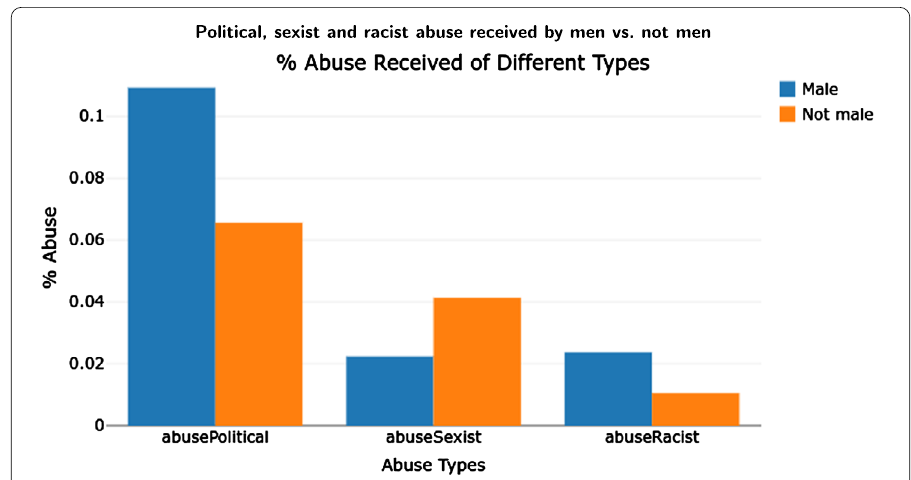
Figure 7 Political, sexist and racist abuse received by men vs. not men. Political, sexist and racist abuse received by male vs. non-male candidates as a macro-averaged percentage of all replies received